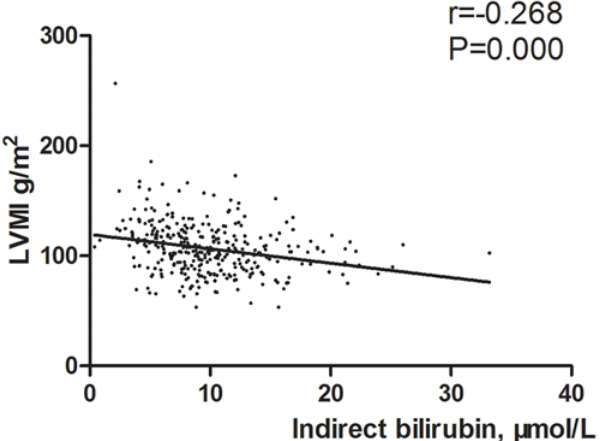
Fig 2. Scatter diagram of indirect bilirubin level between the